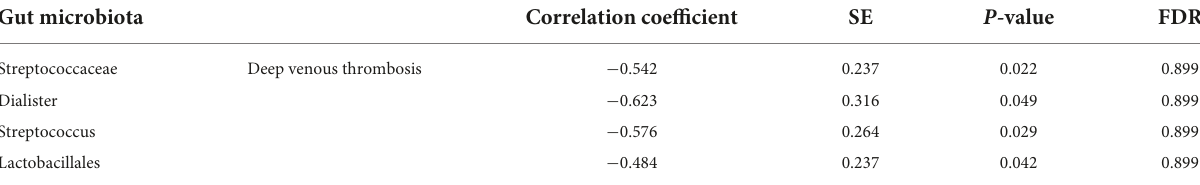
TABLE 1 Genetic correlation between gut microbiota and deep venous thrombosis. Gut microbiota